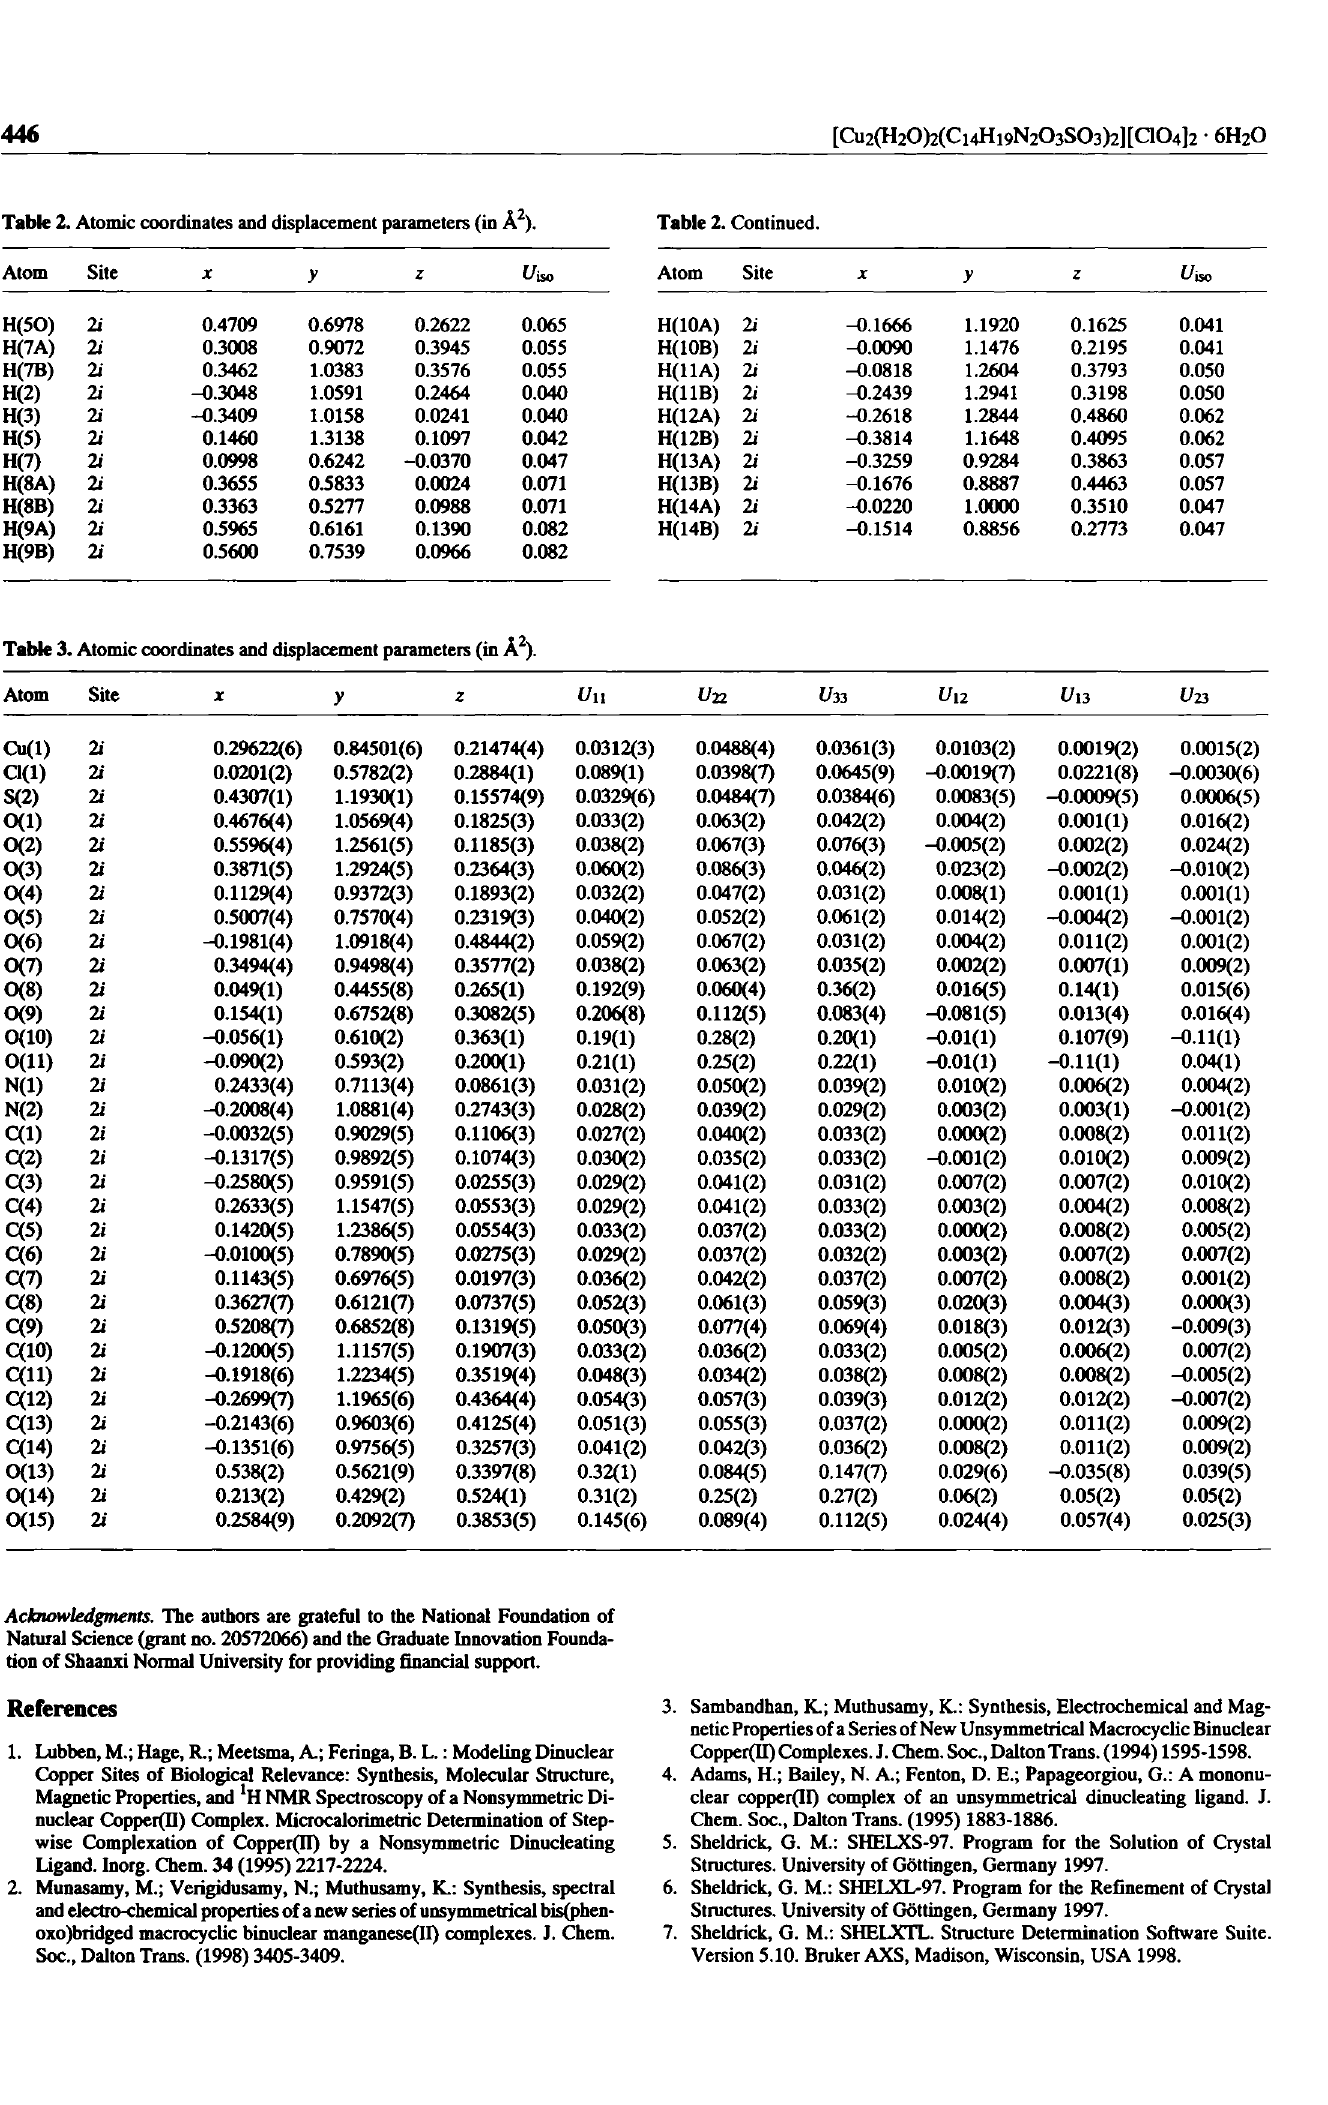
Table 3. Atomic coordinates and displacement parameters (in Ä 2